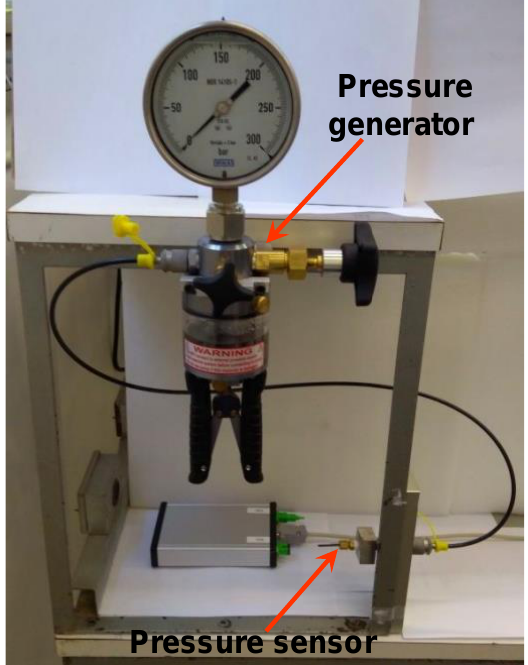
Figure 11. Static pressure generator used in the leakage test.